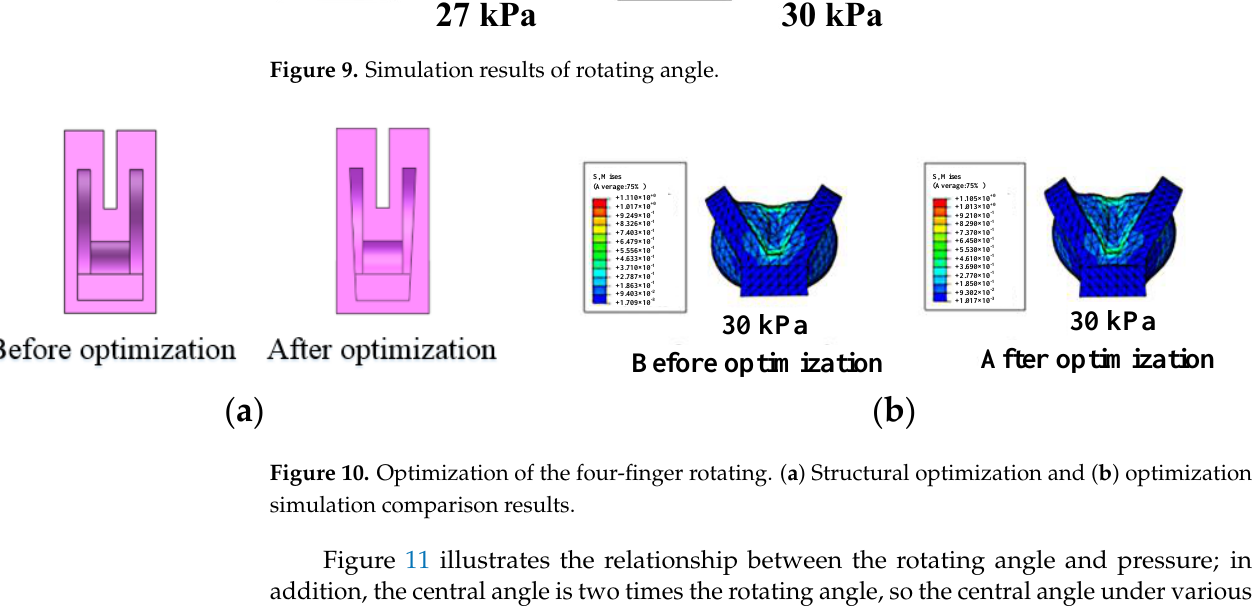
Figure 10. Optimization of the four-finger rotating. ( a ) Structural optimization and ( b ) optimization simulation comparison results.